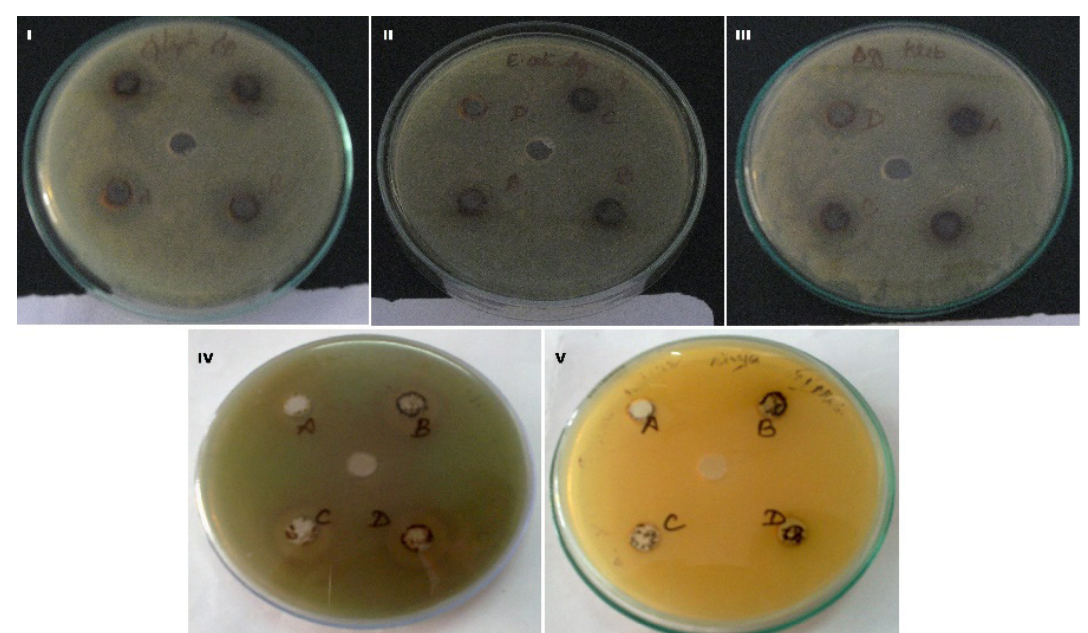
FIGURE 5 – MHA plates showing antibacterial activity of M. arvensis Linn. mediated silver nanoparticles against indicator